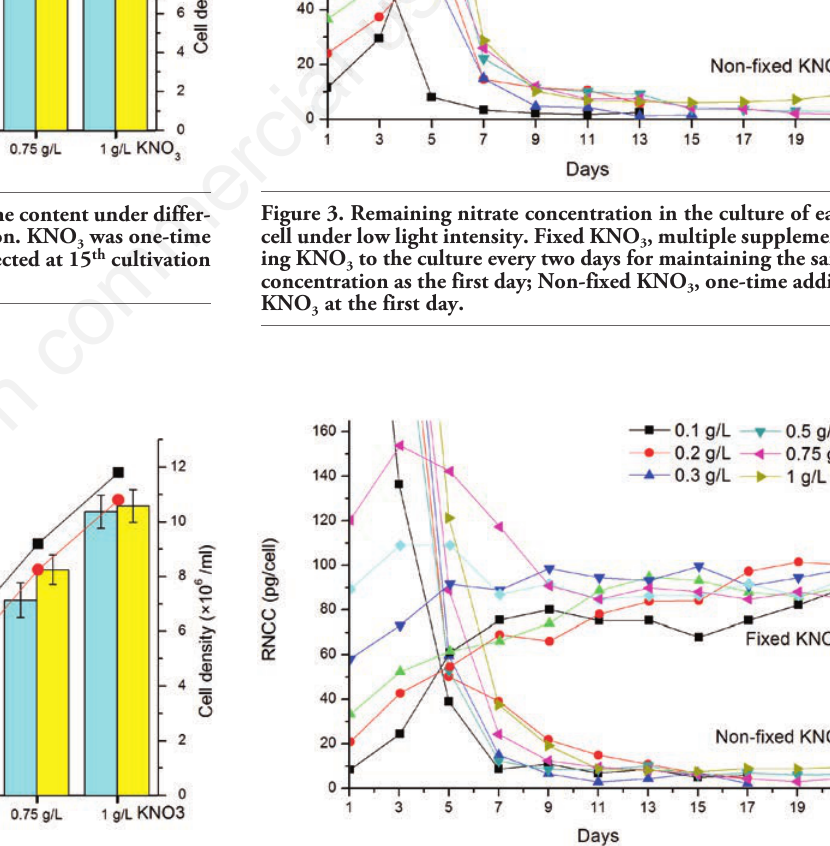
, multiple supple- 3 , one-time 3